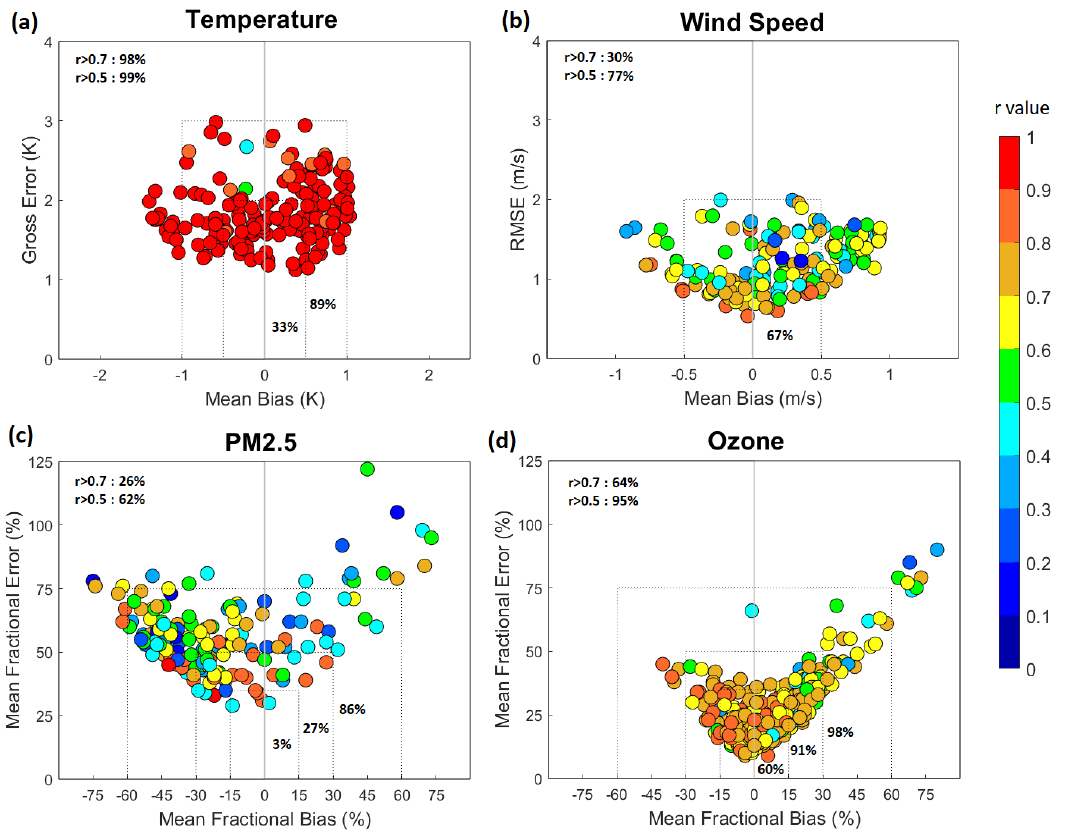
Figure 2. Soccer plots showing model performance against AQS measurements for ( a ) 2 m tempera- ture; ( b ) 10 m wind speed; ( c ) surface PM 2.5 concentration and ( d ) surface ozone mixing ratios. The color scale represents the correlation coefficient (r) value. The goal lines are shown as dotted lines. The percentage of data points lying within each goal line is shown in the figure (within goal lines). Furthermore, the percentage of data points having an ‘r’ value greater than 0.5 and 0.7 are shown on the top left of each figure.